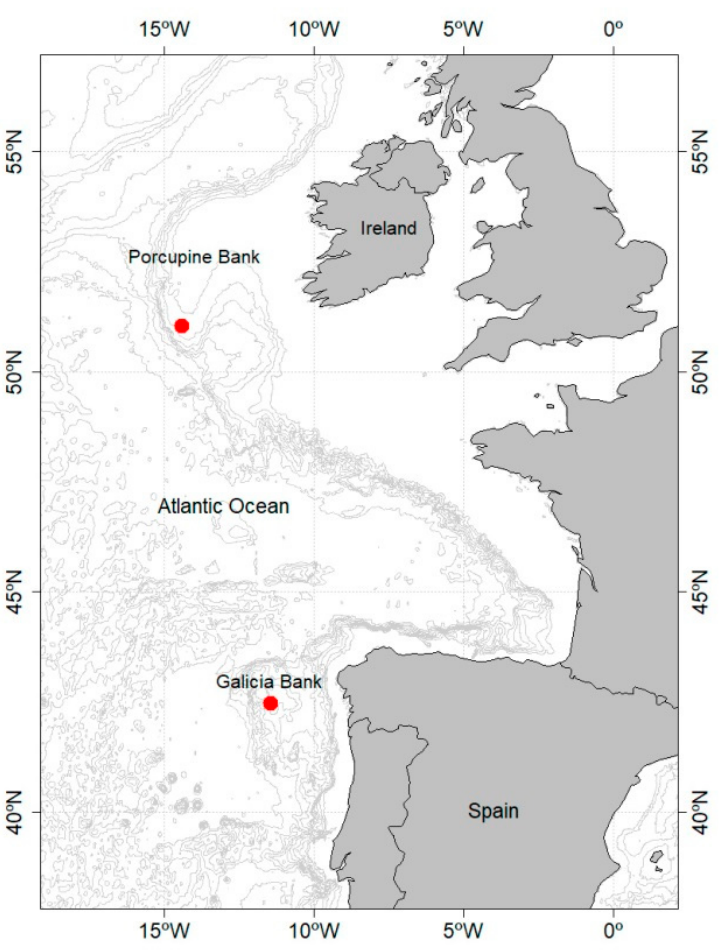
Figure 1. Map showing the location of catches of Gaidropsarus gallaeciae sp. nov. specimens in the Galicia and Porcupine Banks, in the northeast Atlantic .